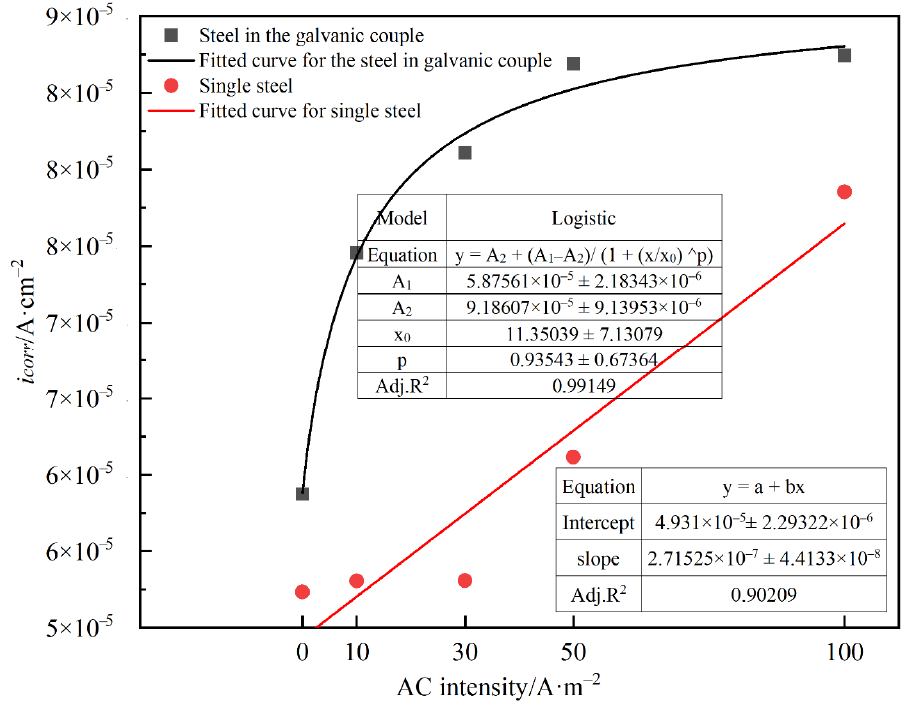
Figure 10. The curves of fitted corrosion current density for the steel in the galvanic couple and single steel electrode samples varied with AC interference intensities.